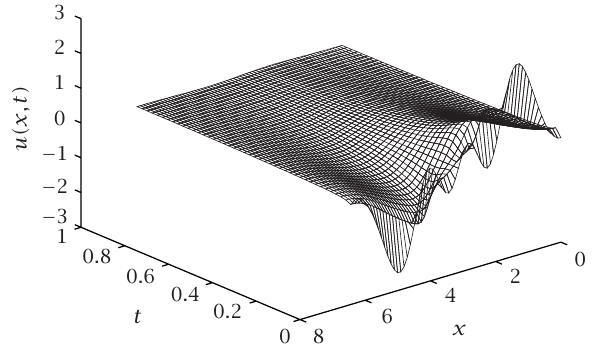
Figure 4.4 . Time evolution of the controlled Burgers equation (3.1) when n = 3, m = 0 . 1, ν = 0 . 3, (a,b,c,d) = ( 1 , 0 , 1 , 0 ) , and r j = 10, j = 1 ,...,